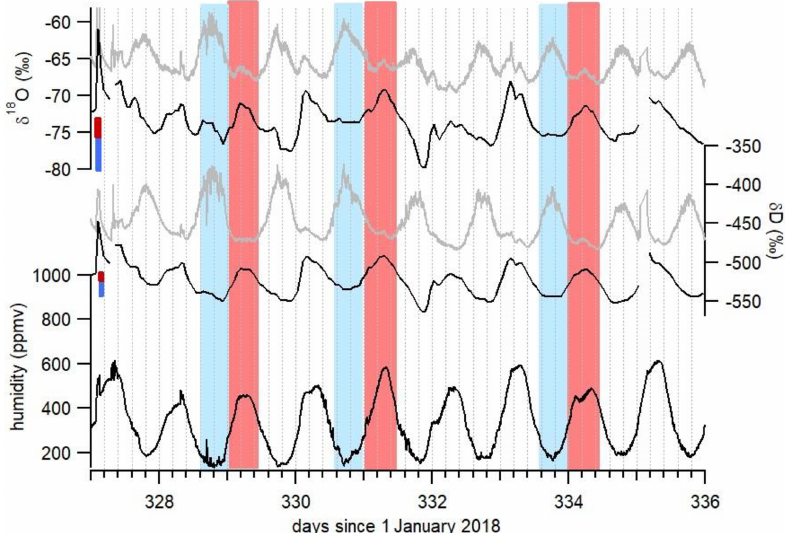
Figure 7. Focus on diurnal variability of δ 18 O, δ D and humidity recorded at Concordia. Gray curves show the raw measurements, and black curves show the corrected records. The red (blue) bars indicate the calculated uncertainty due to the isotopic ratio vs. humidity dependence (Fig. 5) on the corrected δ 18 O and δ D values during periods with maximum (minimum) humidity. The red (blue) rectangles indicate a half-day with maximum (minimum)